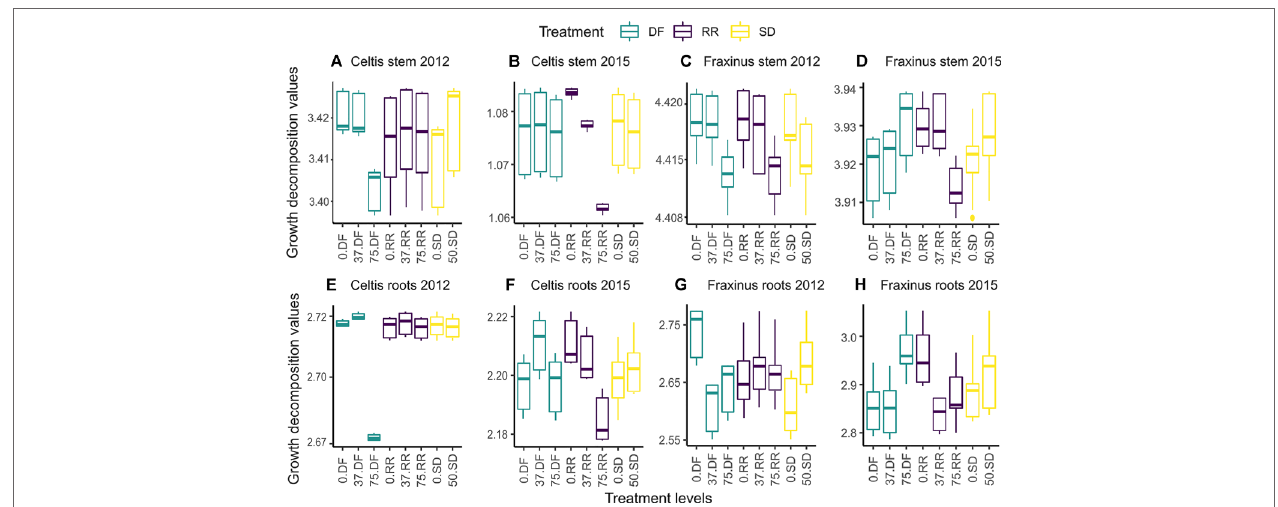
FIGURE 6 | Partial dependence plots showing tree ring growth decomposition between the different levels of damage treatments obtained by the GBM model for the first year (2012) and last year (2015) following damage treatment. DF, defoliation; RR, root reduction; and SD = stem damage, 0 = null treatment, 37 = low intensity treatment, 75 = high intensity treatment. Panels (A and B ) for the stem growth of Celtis , (C and D) for the stem growth of Fraxinus , (E and F) for the root growth of Celtis , and (G and H) for the root growth of Fraxinus . Scales are different in each panel to maximize the visibility of the differences between the treatment levels. The vertical lines represent the “whiskers” for the 5th and 95th percentiles of the data distribution.